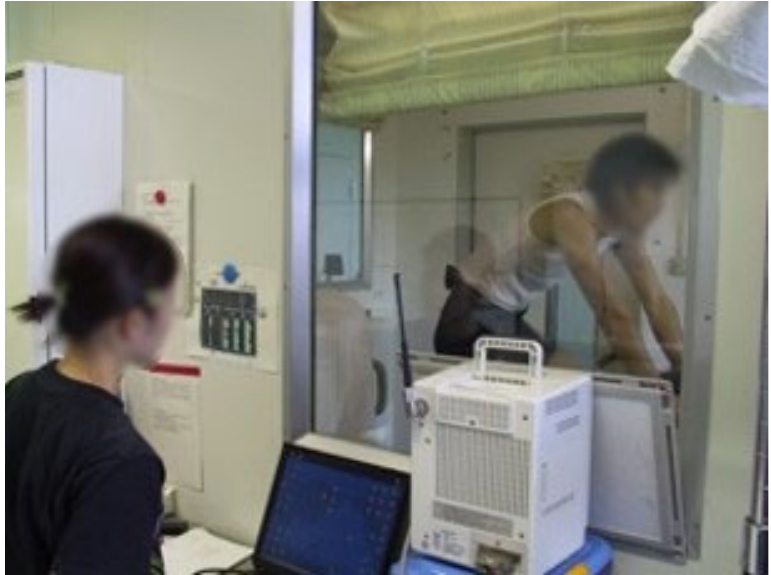
Figure 3. Whole ‐ room indirect calorimetry. Changes in O chamber are measured to assess O 2 uptake and CO 2 production of the participants without a mask and mouthpiece. This system, also known as a human calorimeter, allows us to track energy metabolism over time, including during sleep [37]. This method has limitations in assessing dynamic changes in energy metabolism caused by the dilution of the expired air with chamber air. Hence, efforts have been made to improve time resolution of the system [38].